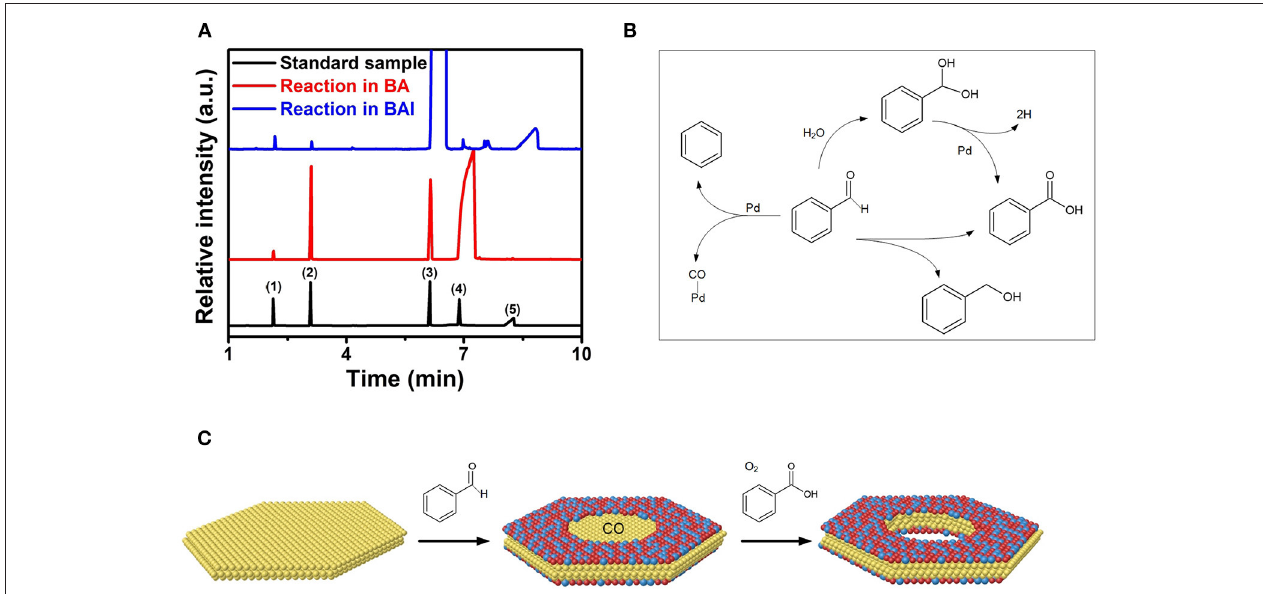
FIGURE 3 | (A) GC-MS spectra of three residual solutions including the reaction solution of Pd@PtRh nanorings, nanoplates, and the standard sample containing (1) benzene, (2) toluene, (3) BAl, (4) BA, and (5) benzoic acid. (B) Possible reaction pathways for BAL under the solvothermal process in the presence of the Pd nanoplates. (C) Scheme for the epitaxial growth and in-situ etching of Pd@PtM (M = Rh, Ni, Cu, Pd) nanorings realized by interface catalytic reactions.